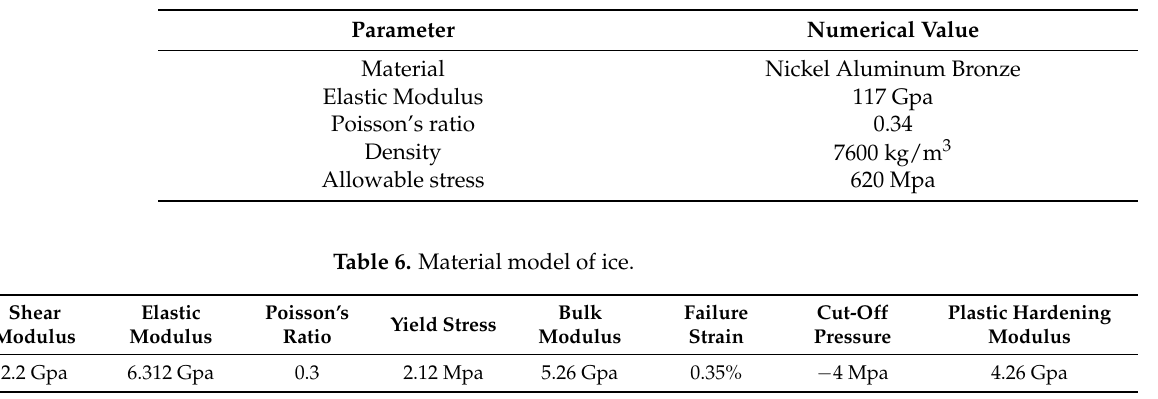
Table 5. Material model of propeller.